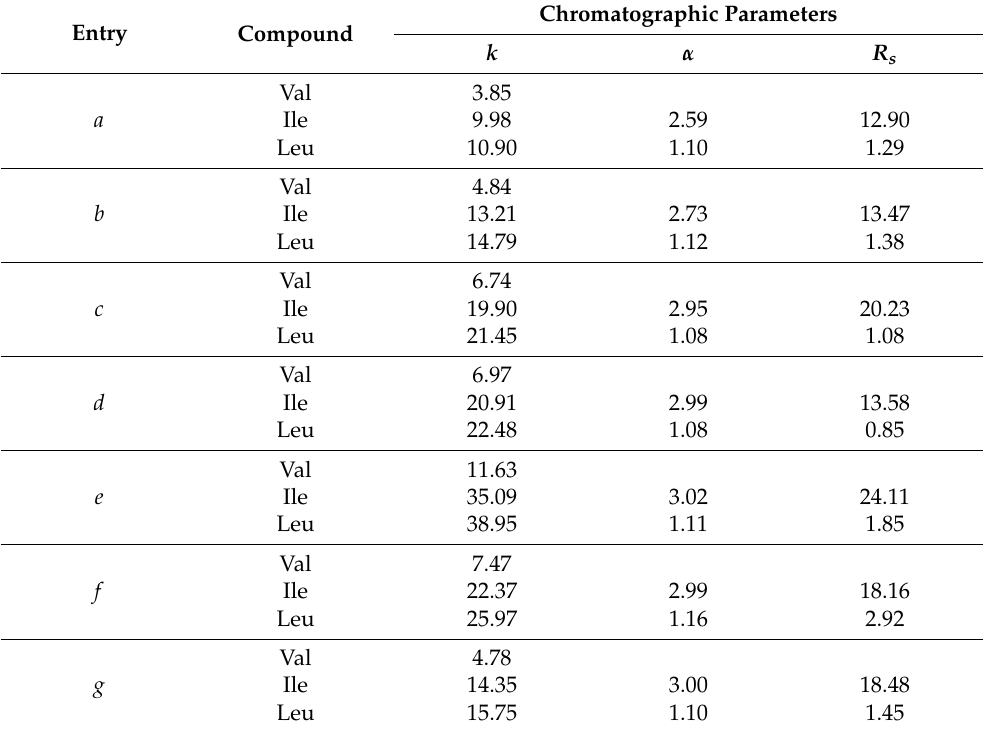
Table 1. IP-RP-HPLC performance obtained under the tested experimental conditions (details are reported as footnotes and in Section 2.3); k : retention factor; α : separation factor; R S : resolution factor. All of the analyses were observed at 220 nm. F.r.: eluent flow rate. Separation and resolution factor values refer to two consecutive peaks in the chromatogram. Chromatographic Entry Compound